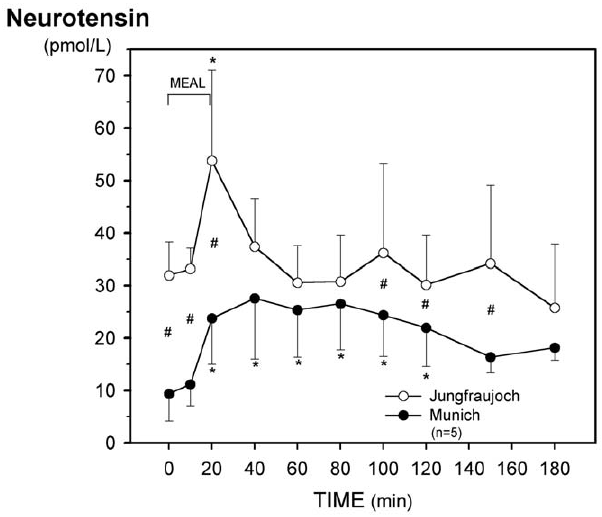
Figure 4. Effect of acute exposure to high altitude (Munich, 490 m, to Jungfraujoch, 3454 m) on postprandial plasma levels of neurotensin. Asterisks (*) indicate a significant increase (p , 0.03) as compared with the preprandial values at 0 min and crosses ( # ) mean a significant (p , 0.03) difference between the respective values at the two sea levels.